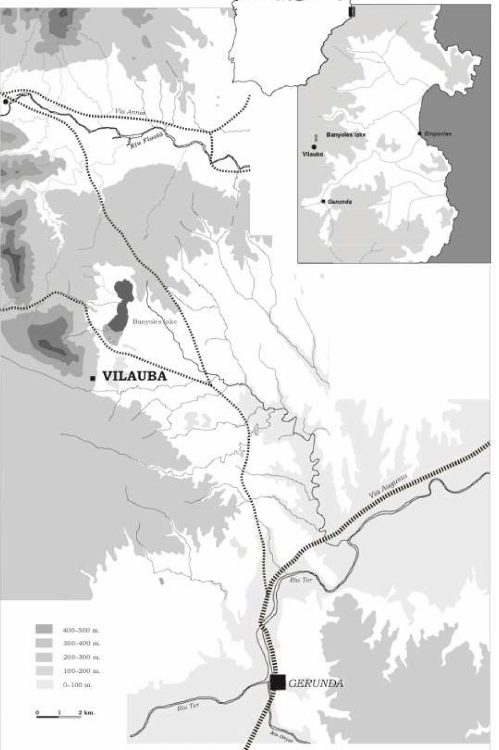
Figure 1. Location of Vilauba in relation to the most important Roman towns in the area.